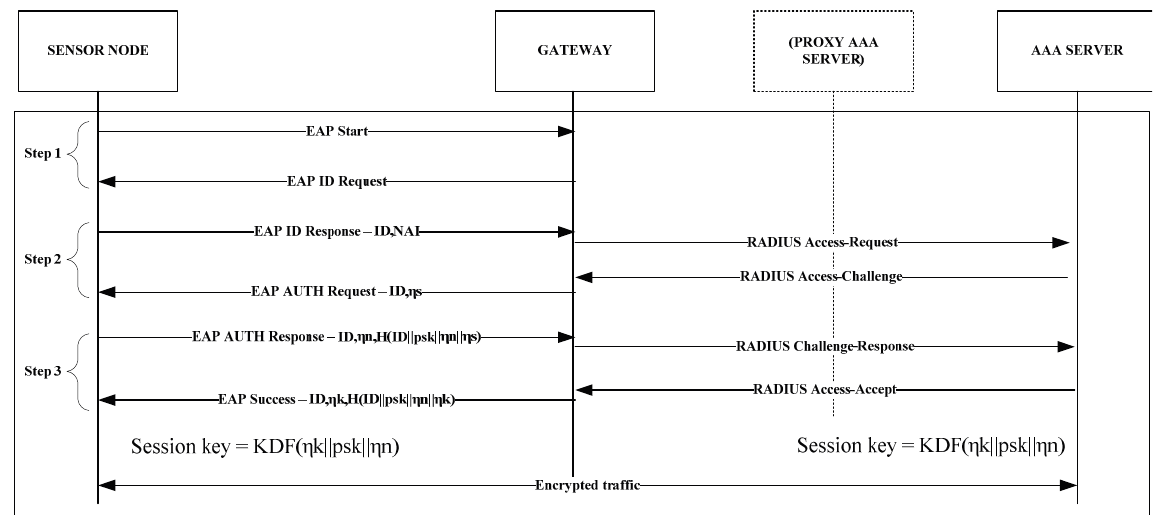
Figure 3. The EAP-Swift protocol authentication and session encryption key generation steps, including message